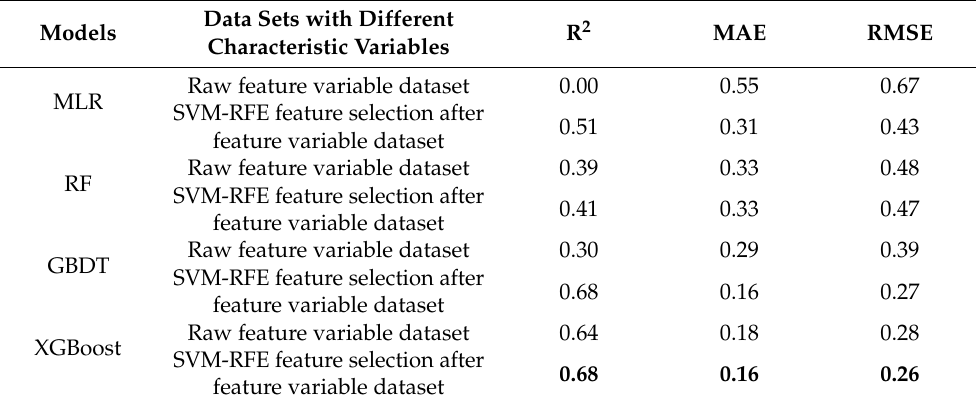
Table 6. Comparing accuracy before and after feature selection for different machine learning models. Bold rows are shown as the most accurate